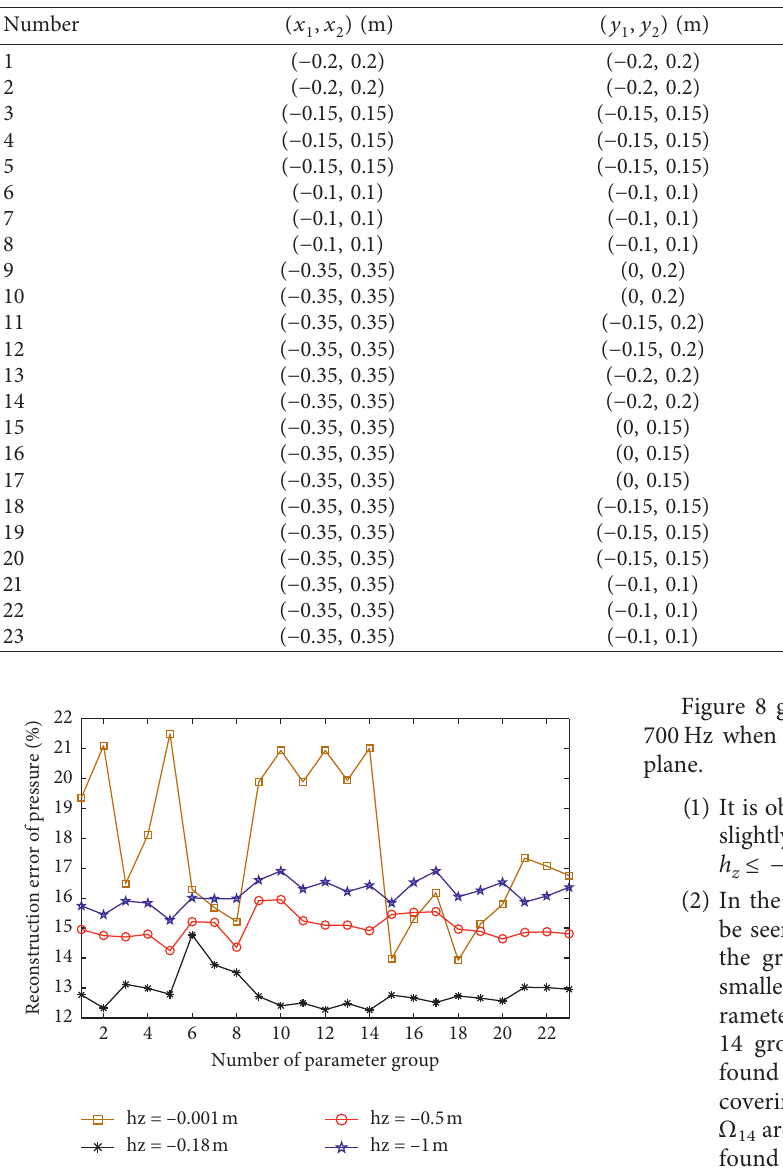
Figure 7: The reconstruction errors of pressure when using dif- ferent CRP configurations with a marble floor as the reflecting